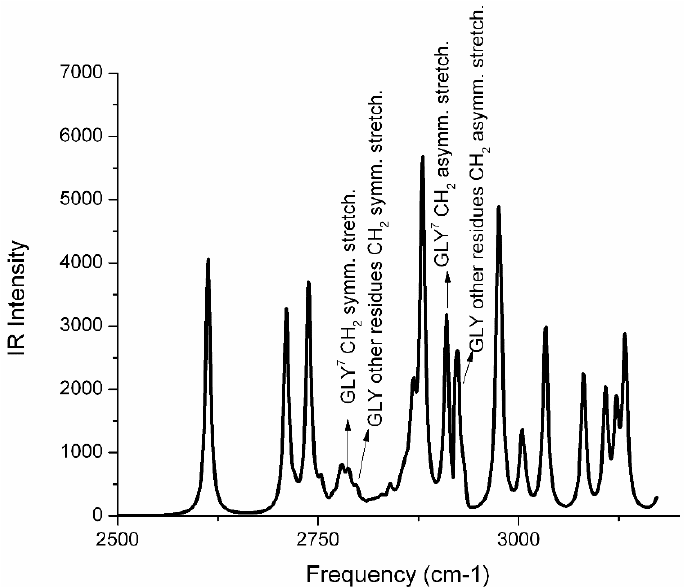
Figure 2. QM—simulated IR spectrum of two proximal A β (1-40) α -helices of a tetramer ion-channel pore as reported in Figure 1D. The amino acid sequence is reported in the Materials and Methods section. A hydrogen bond is established between the C α -H of Gly29 (in spectrum numbered as Gly7) and the C=O group of Asp23.